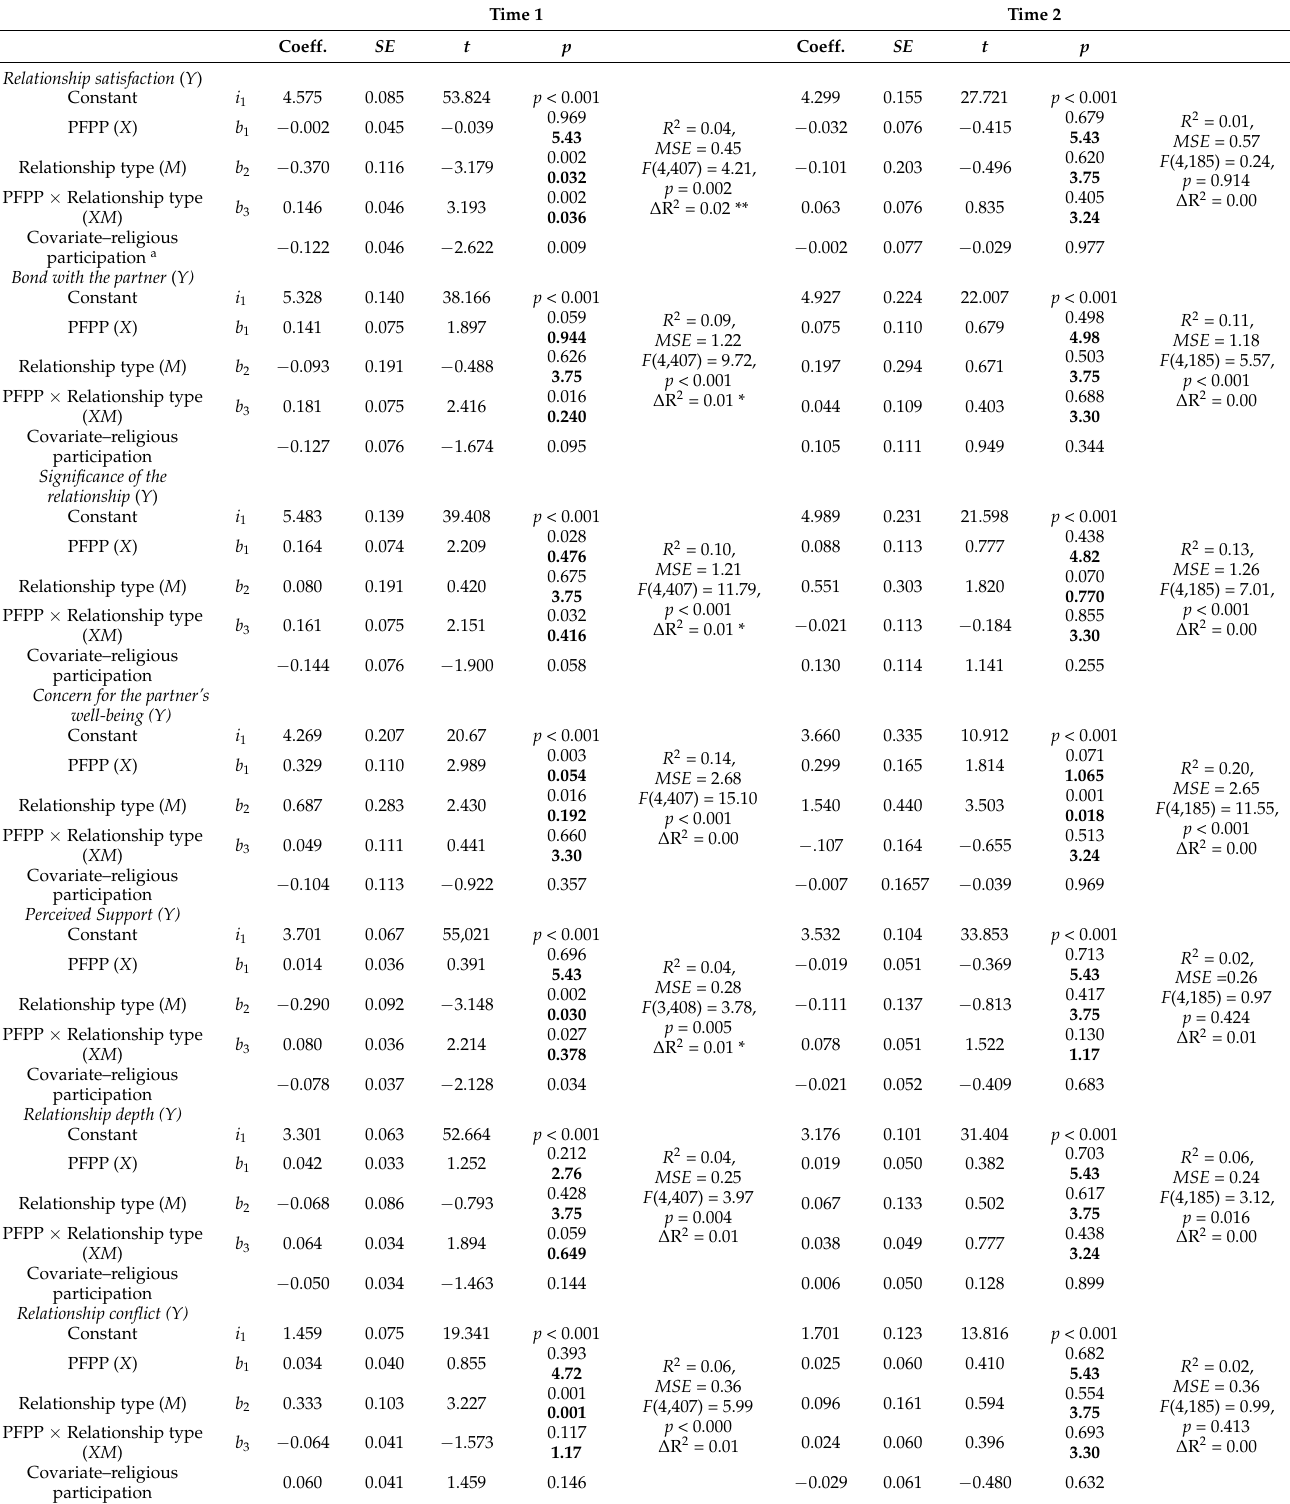
Table 2. Results from Regression Analyses Examining the Moderation of the Effect of Partner- Focused Petitionary Prayer on Relationship Outcomes at T1 and T2 by Relationship Form (Marital vs. Nonmarital